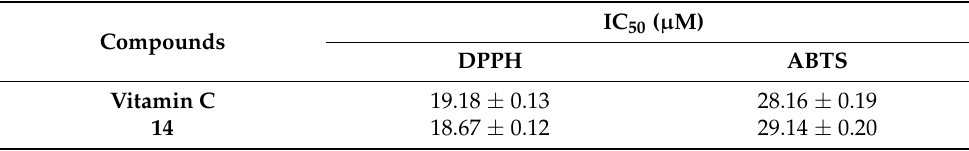
Table 4. The OSe compounds 14 redox properties.